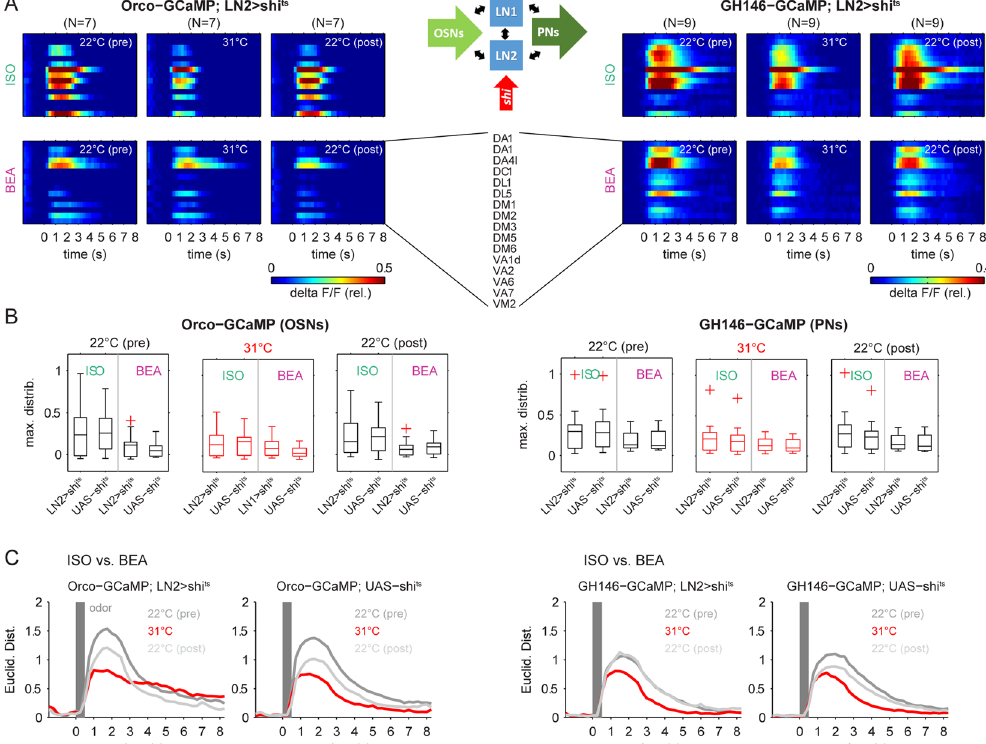
Figure 4. Silencing synaptic transmission of local interneurons type 2 (LN2). ( A ) Synaptic transmission of LN2 was silenced by expressing shi ts under the control of the enhancer trap line NP2426-GAL4 while calcium signals were monitored in OSNs (left: Orco) and PNs (right: GH146, see scheme part (iii) in Fig. 1 for details). False color coded mean activity of 15 glomeruli for the three experimental phases during the presentation of ISO (upper panels) and BEA (lower panels). ( B ) Comparison of the odor-evoked maximal fluorescence distributions between the parental control (UAS- shi ) and the experimental line (LN2 > shi ts ) reveals no significant differences between the permissive and non-permissive temperatures, neither for the OSN nor for the PN activity (ANOVA, p > 0.05). ( C ) The odor evoked population vector activity (shown in A) was used to calculate Euclidean distances between both odor representations separately in every experimental phase. The temperature increase to 31 °C led to a drastic decrease in the Euclidean distances (red) in OSN (left) as well as in PN activity (right). At the permissive temperature during the recovery phase, the Euclidean distances increased again but did not completely recover. However, we observed the same effect for the parental control (UAS- shi OSNs, N = 9; UAS- shi PNs, N =